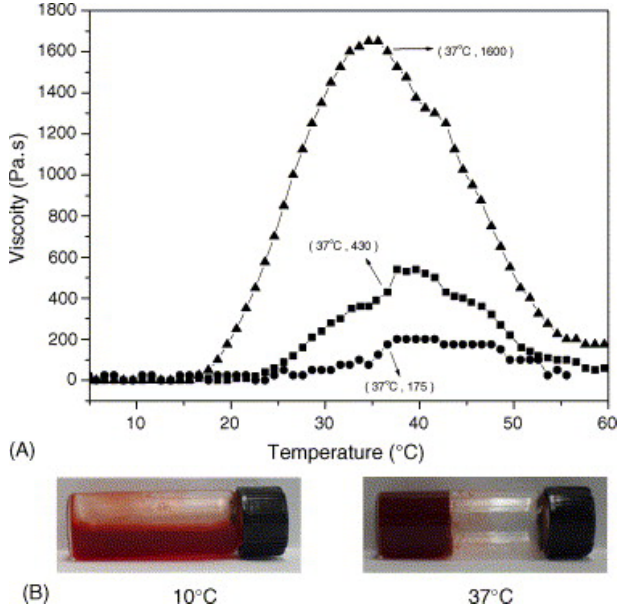
Figure 13. ( a ) Change of viscosity with temperature of polyphosphazenes cosubstituted = 550) and isoleucine ethyl ester and glycyl lactate ethyl ester groups at with mPEG (M n polymer concentrations of 7 wt. % ( ● ), 10 wt. % ( ■ ), and 15 wt. % ( ▲ ). ( b ) Reversible gelation behavior is observed at temperatures between 10 and 37 °C. Reprinted from [121]), with permission from